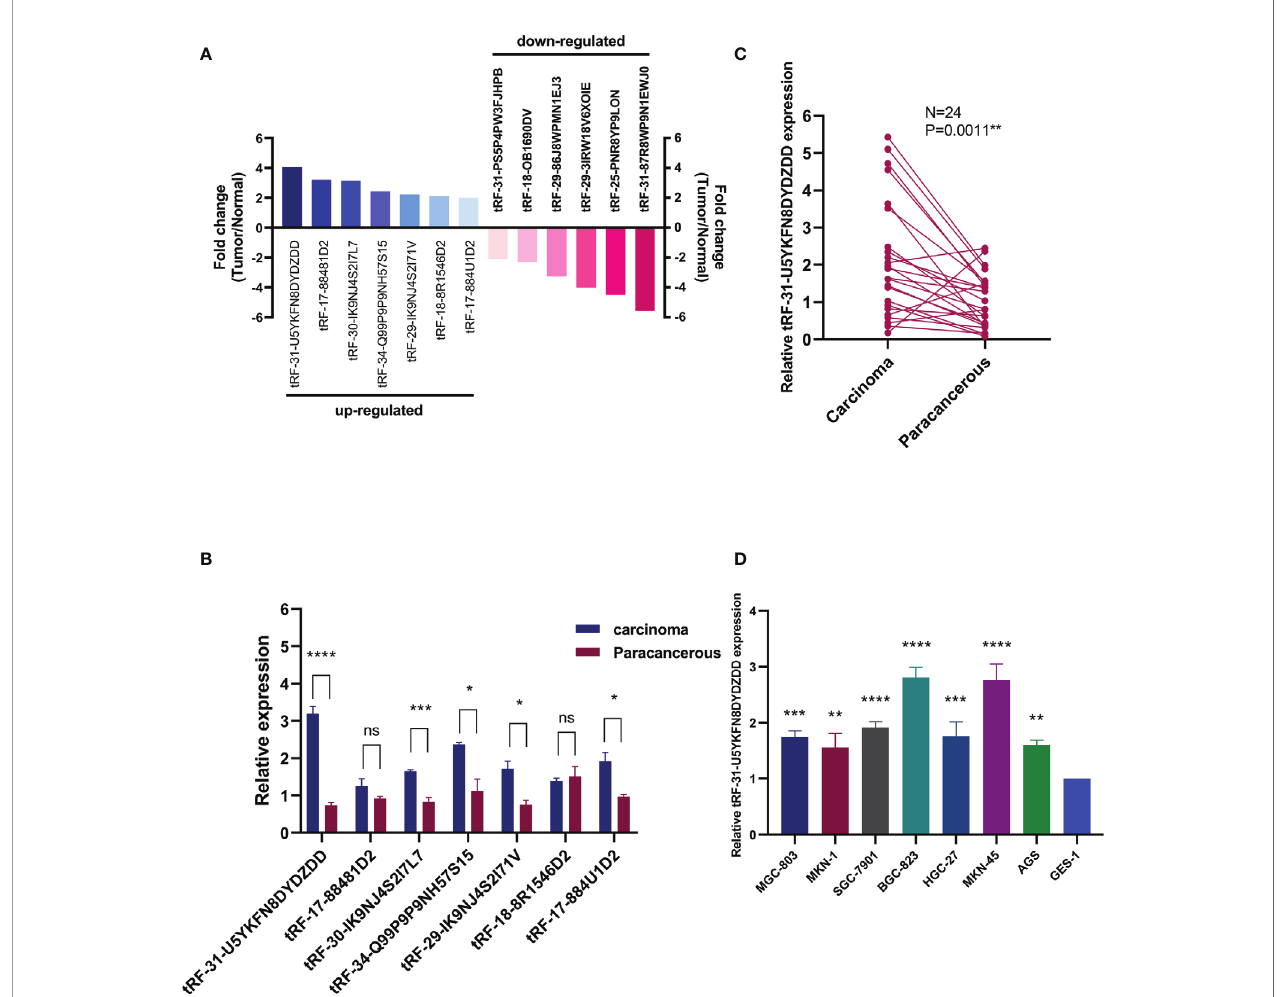
FIGURE 1 | Expression of tRFs in GC tissues and cell lines. (A) Differential expression results of tRFs-seq for GC vs. matched paracancerous tissues, including seven upregulated and six downregulated (fold change > 2.0, P < 0.05) . (B) The expression levels of tRFs in GC tissues and their paired adjacent paracancerous tissues. (C) Expression of tRF-31-U5YKFN8DYDZDD was quanti fi ed by qRT-PCR in tissues, and its expression is normalized by U6 RNA in each sample. (D) Expression of tRF-31-U5YKFN8DYDZDD in GC cells and normal gastric mucosal epithelial cell line (GES-1). U6 was used for normalization. *Indicated statistical signi fi cance (****P < 0.0001, ***P < 0.001, **P < 0.01, *P < 0.05); NS, no signi fi